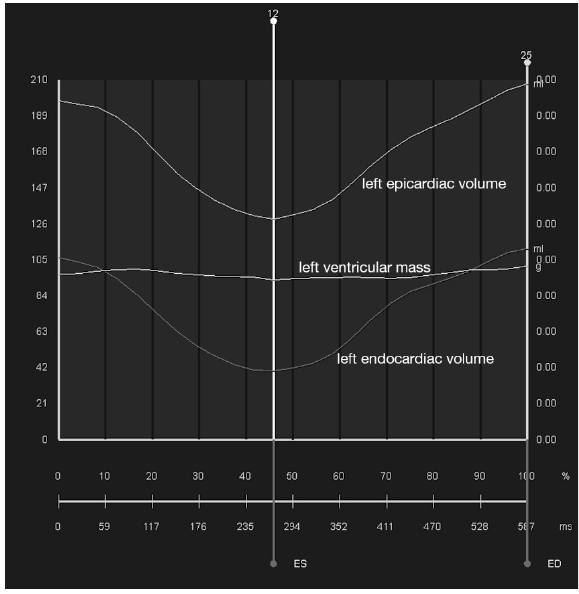
Figure 3. Evaluation of epicardial and endocardial volume and cardiac mass over the entire cardiac cycle. Ideally, the mass line is horizontal over the entire cardiac cycle.